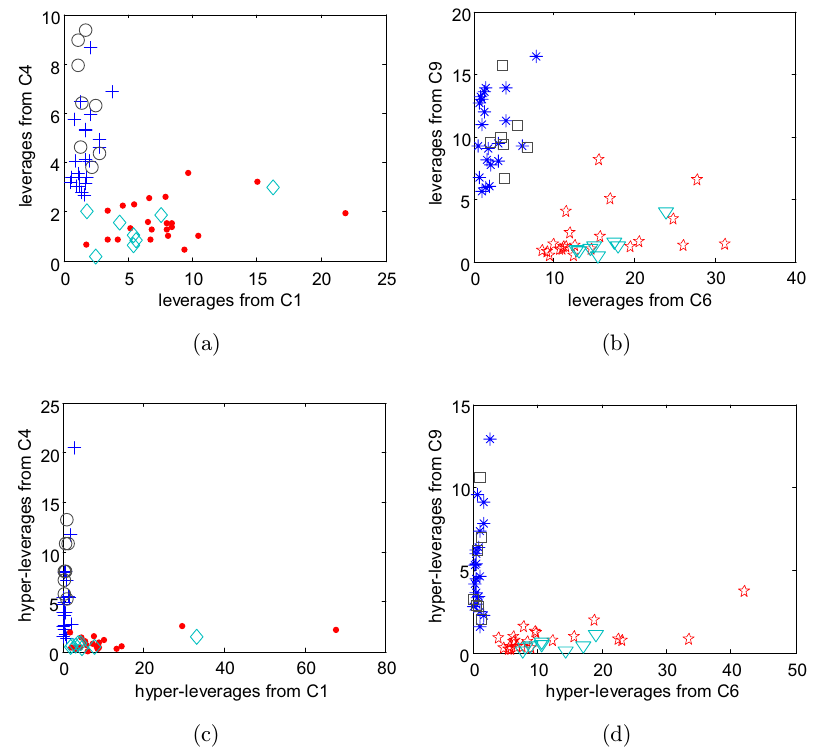
Fig. 4. The leverages and hyper-leverages plot: (a) leverages from C1 and C4; (b) leverages from C6 and C9; (c) hyper-leverages from C1 and C4; (d) hyper-leverages from C6 and C9. The ðþ ; (cid:7) Þ ; ð C1, C4, C6, C9,